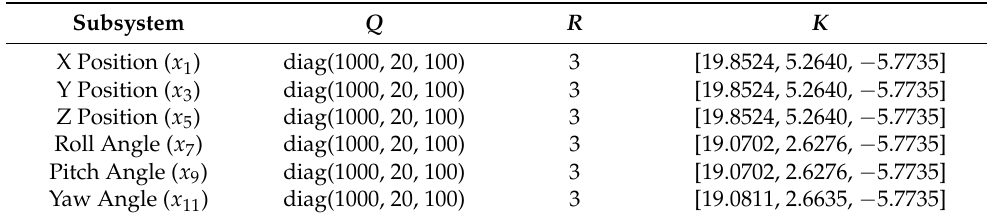
Table 18. Q and R matrices used in the LQR optimal gain calculation and the resulting optimal gains for each